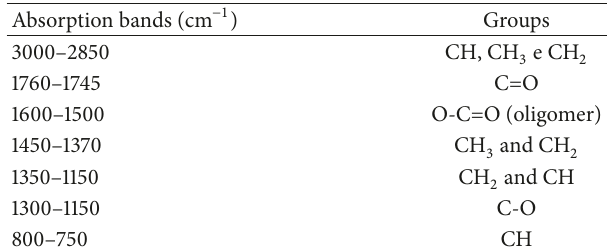
Table 4: Absorption bands identified in the FT-IR assay character- istic of the functional groups present in the PLGA